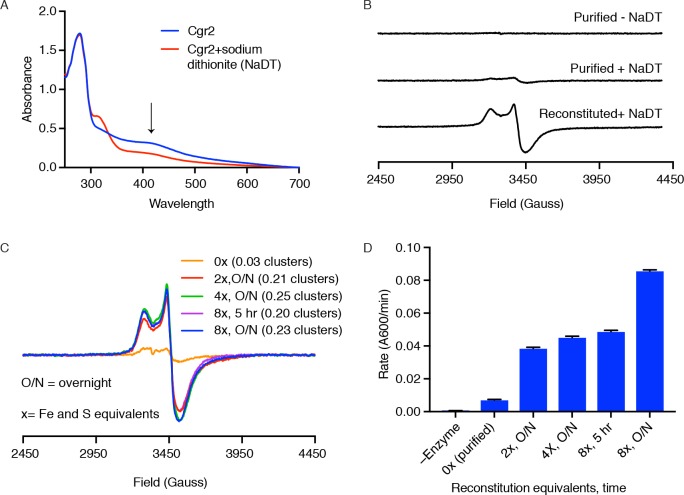
Cgr2 activity, but not EPR-active [4Fe-4S] clusters, increase with higher Fe and S equivalents.(A) Ultraviolet-visible (UV-Vis) spectra of reconstituted Cgr2 in the absence or presence of reducing agent sodium dithionite (NaDT) revealed that the [Fe-S] clusters in Cgr2 are redox active. (B) Purified Cgr2 did not exhibit a detectable EPR signal. Upon reduction with NaDT, an EPR signal corresponding to [4Fe-4S]1+ clusters was detected in purified Cgr2. This signal was amplified in reconstituted Cgr2, showing incorporation of additional [4Fe-4S] cluster(s). Samples contained 200 µM protein, 0.2 mM sodium dithionite, and EPR measurements were conducted at 10 K. (C) EPR spectra of dithionite-treated Cgr2 samples that had been reconstituted with 0 (purified), 2, 4, or 8 equivalents of iron and sulfide for 5 hours or overnight (O/N). Samples contained 150 µM protein, 0.3 mM sodium dithionite, and measurements were conducted at 10 K. Number of EPR-active clusters per Cgr2 monomer under each reconstitution condition is shown in parentheses. Spin quantitation was determined against a 150 µM Cu2+-EDTA standard measured under non-saturating conditions. (D) In vitro reaction rates of Cgr2 reconstituted under different conditions revealed increasing activity with higher reconstitution equivalents. Data represents mean ± SEM (n = 3 independent experiments).